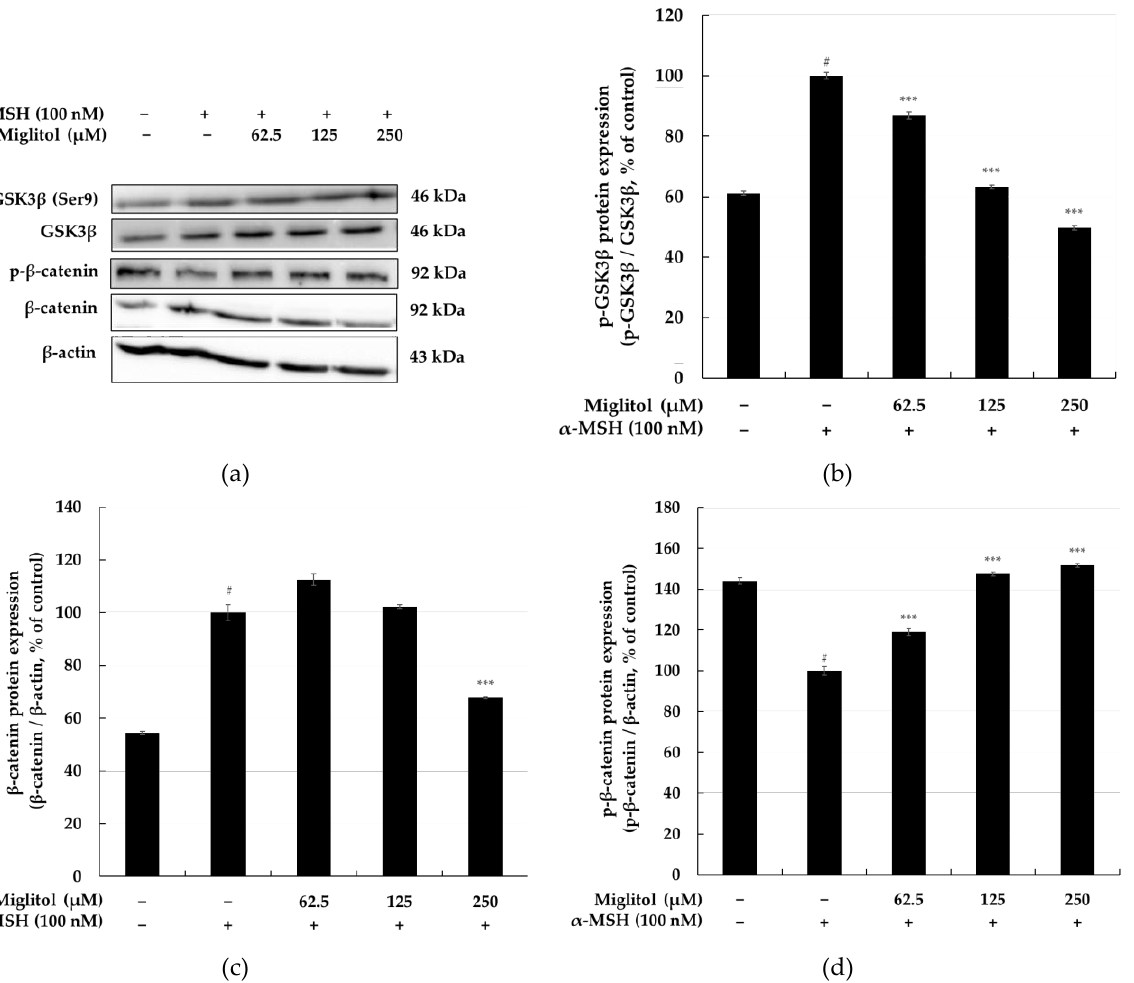
Figure 7. Effects of miglitol on the Wnt/ β -catenin signaling pathway in α -MSH-induced B16F10 melanoma cells. ( a ) Western blotting results and ( b ) GSK3 β , ( c ) β -catenin, and ( d ) p- β -catenin protein expression. Western blot analyses of the dose-dependent effect of miglitol (62.5, 125, and 250 µ M) on the expression levels of GSK3 β , β -catenin, and p- β -catenin in B16F10 cells treated with α -MSH (100 nM) for 24 h. Equal amounts of protein loading were confirmed using β -actin. Data are expressed as the mean SD from a single triplicate experiment using ImageJ software. # p < 0.001 vs. the untreated control group; *** p < 0.001 vs. α -MSH alone.